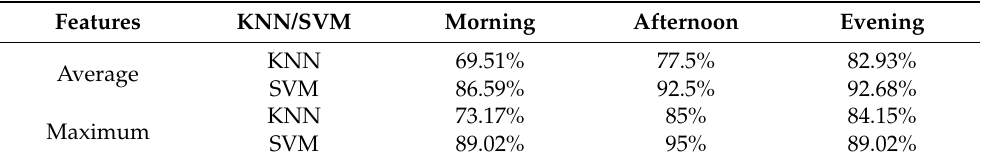
Table 6. The accuracy for odor classification in the same sampling location of chicken house at different sampling